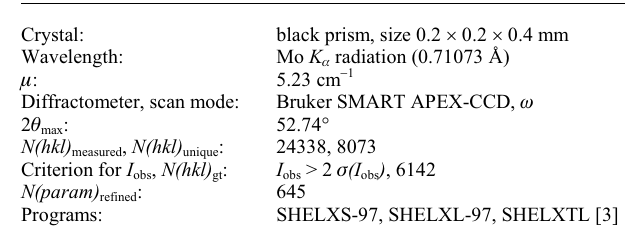
Table 1. Data collection and handling.